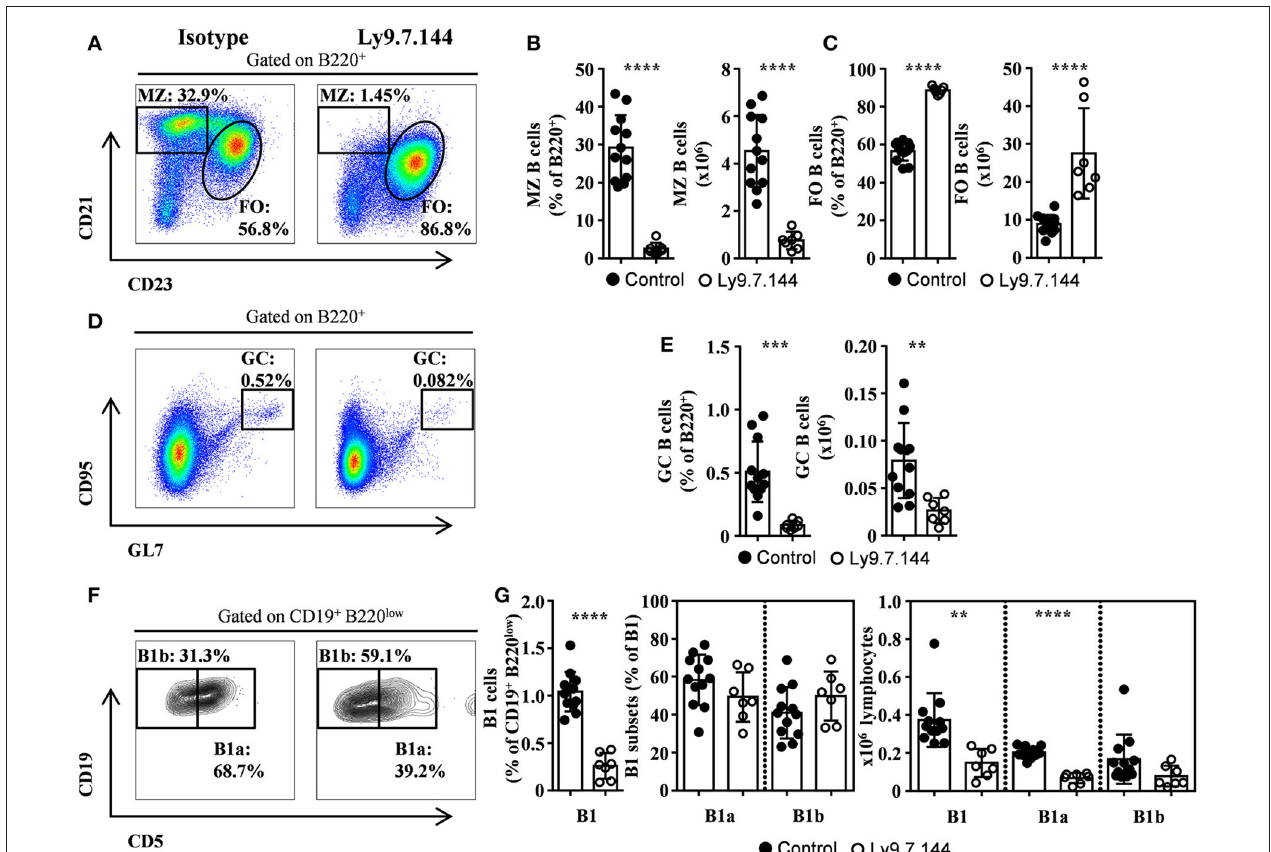
FIGURE 1 | MZ, B1, and GC B cells are depleted by Ly9.7.144 administration in the spleen of SjS mice. Representative dot plots are shown for splenic MZ and follicular B cells (A) , GC B cells (D), and B1 B cell subsets (F) from female NOD.H-2 h4 mice treated with Ly9.7.144 (right plots) or isotype control (left plots). Percentage and absolute counts for the different cell subsets are shown: MZ B cells (B) ; follicular B cells (C) ; GC B cells (E) and B1 B cell subsets (G) . Mice treated with Ly9.7.144 mAb are represented as empty dots and mice treated with isotype control are represented as black dots. Results are expressed as mean ± SD. ** p < 0.01; *** p < 0.001; **** p < 0.0001 (unpaired two-tailed t -test). Data are pooled from three independent